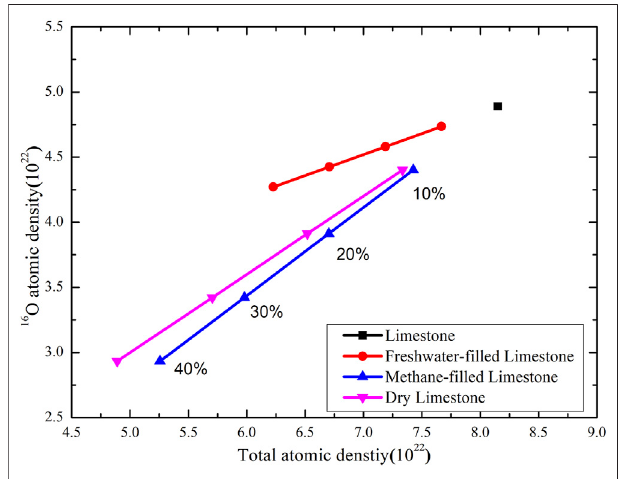
FIGURE 3 | Inelastic scattering cross sections of various nuclides.